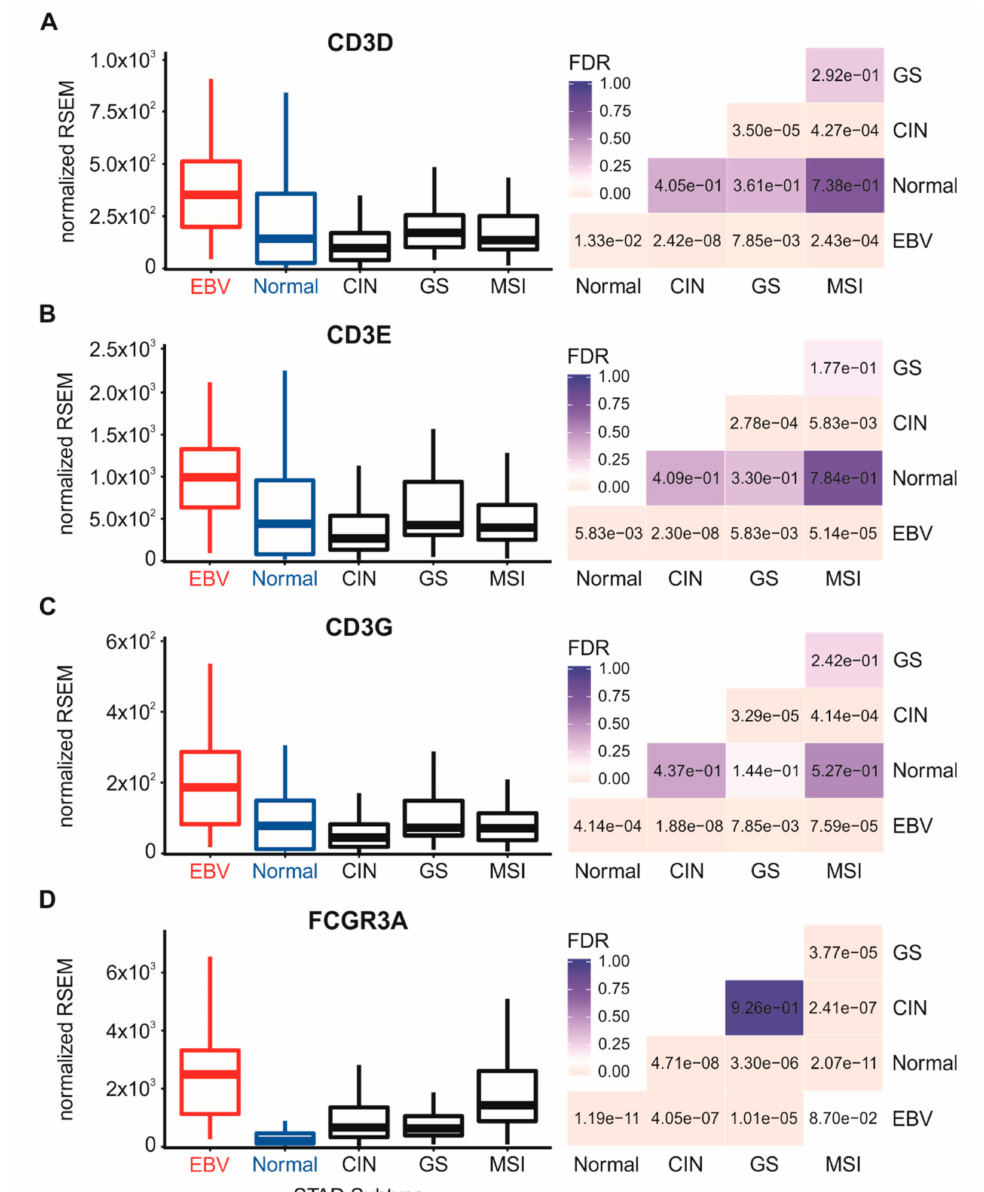
Figure 5. Detection of tumor infiltrating T cells and natural killer (NK) cells in gastric carcinoma subtypes and normal gastric tissue. Normalized RNA-seq data for genes indicative of tumor infiltrating T cells including CD3D ( A ), CD3E ( B ), and CD3G ( C ), or FCGR3A ( D ) for NK cells were extracted from the TCGA database for the STAD cohort for EBVaGCs, normal control tissues, and three other GC subtypes. FDR-adjusted p -values for each statistical comparison are shown on the right for each gene